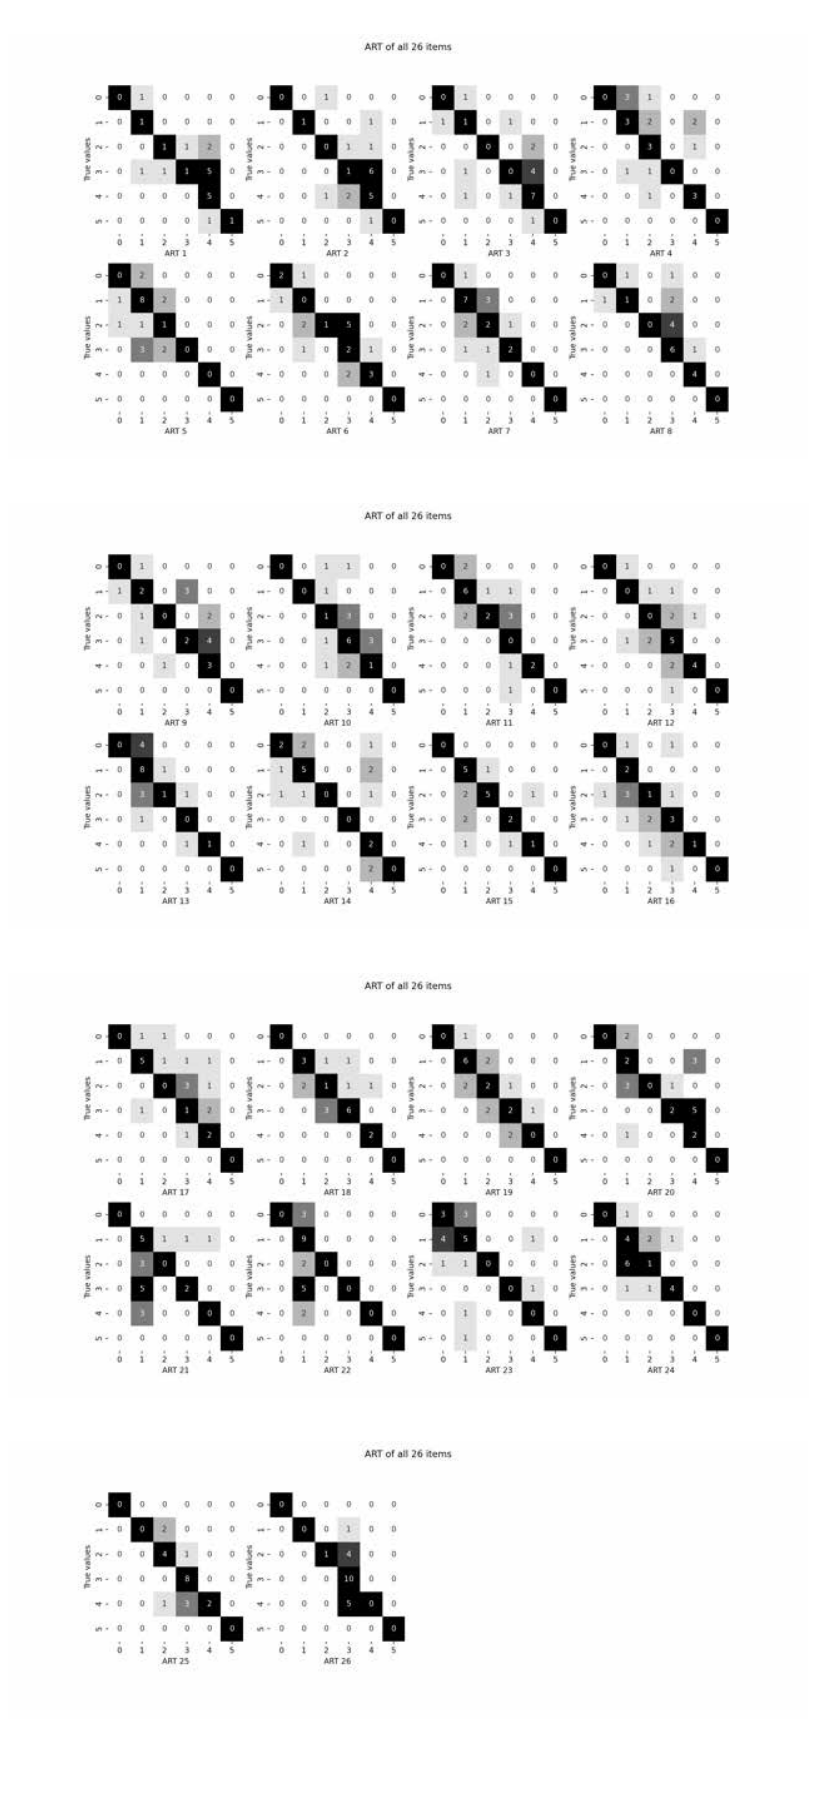
Confusion matrices of the ART for each item’s neural